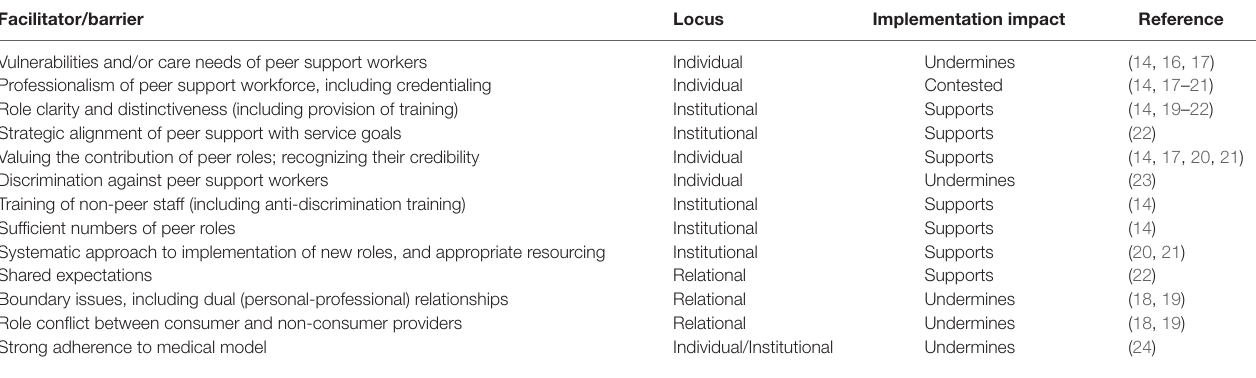
TABLE 1 | Facilitators and barriers to implementing peer support roles within mental health services. Facilitator/barrier